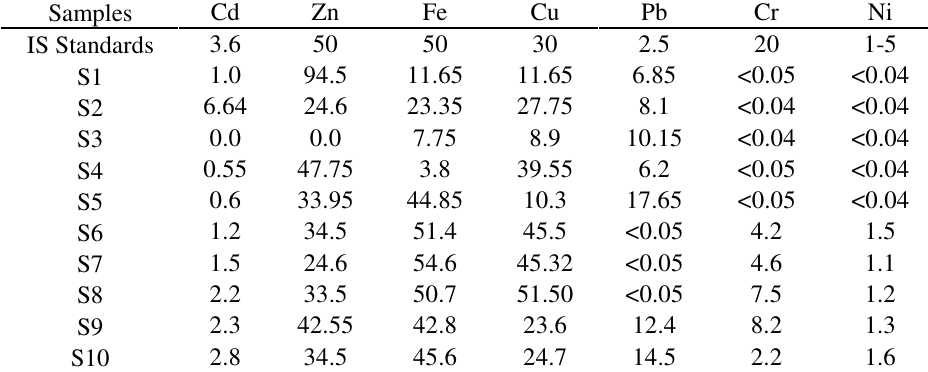
Table 4. Heavy metals (mg/kg of dry wt) in random samples of palak collected from fields around the lakes of Bengaluru Samples IS Standards